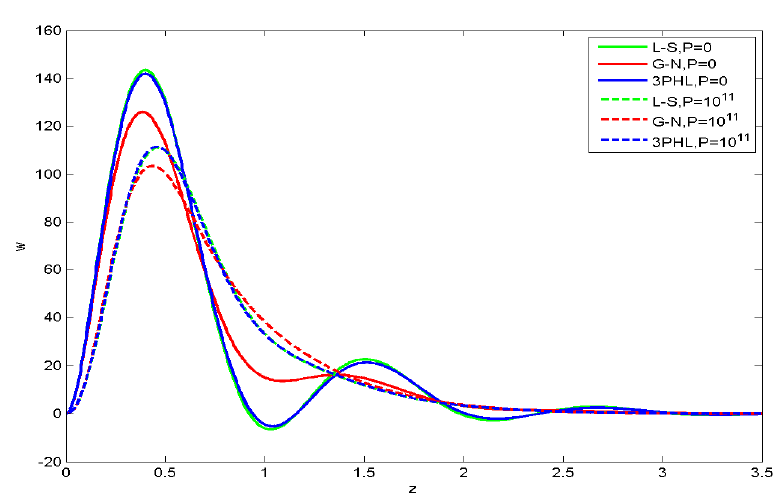
Figure 2. Displacement u concerning z under thermoelastic theories.